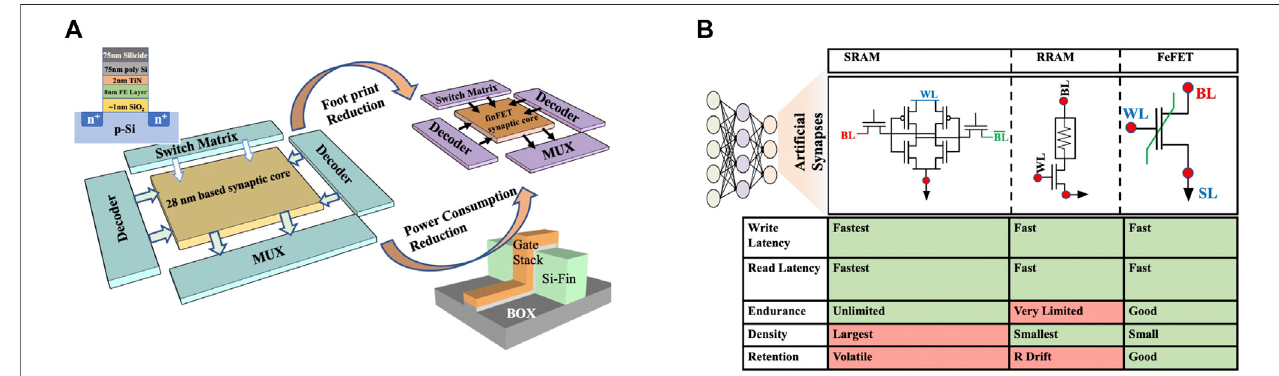
FIGURE 1 | (A) Transition from planar FeFET-based neuromorphic circuits to Fe- fi nFET-based neuromorphic circuit brings several challenges and promises. Although the power consumption and area are reduced, the stochastic variation associated with the scaling will also increase. (B) Qualitative comparison of the critical features of state-of-the-art memory cells highlights the advantage of FeFET as a synaptic